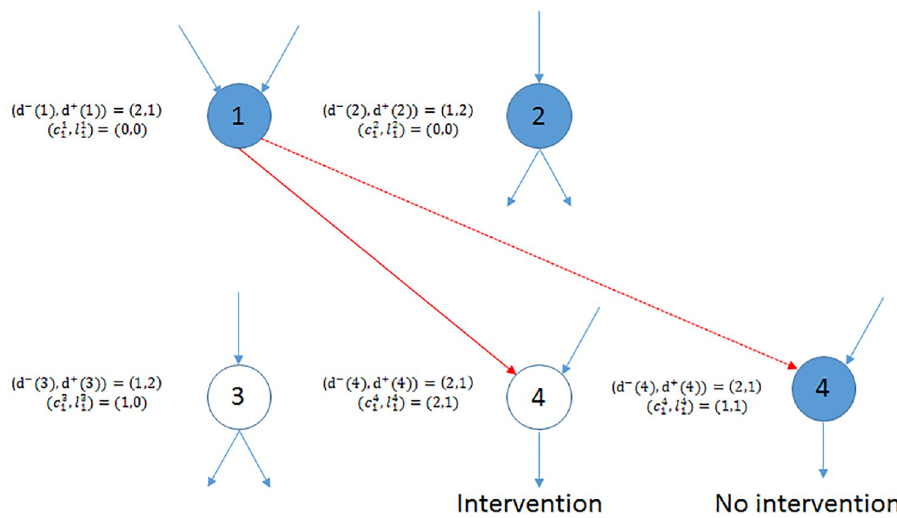
Fig 3. Dynamics at step one. Node 4 is selected with probability 2 intervention is applied, node 4 remains liquid, otherwise its equity level will decrease by one and node 4